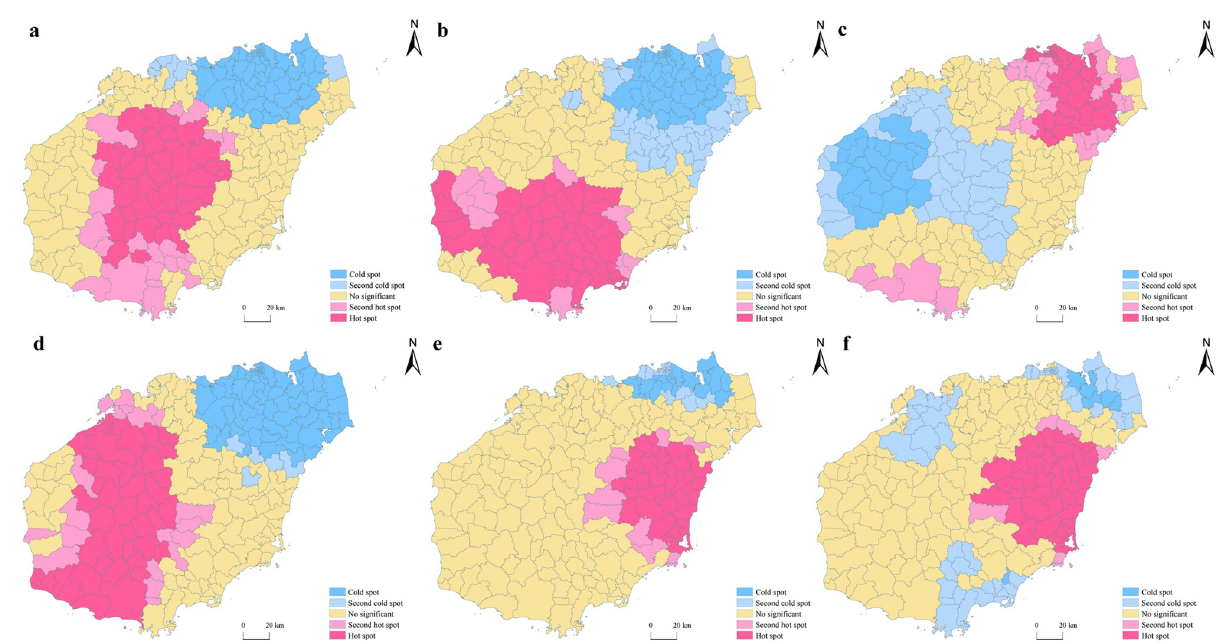
Fig 3. The hot/cold spatial patterns of tourism resources in Hainan (a: Geological Landscape; b: Astronomical Phenomena and Meteorological Landscapes; c: Buildings and Facilities; d: Ruins and Remains; e: Tourist Commodities, f: Human Activities).